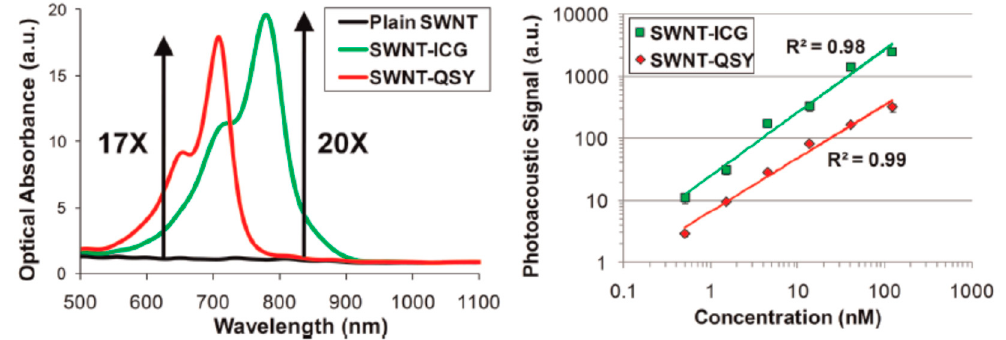
Figure 14. Comparison of absorbance ( left ) and optoacoustic signal ( right ) for ICG (green) and QSY 21 (red) labeled SWNTs. Figure from [101] reproduced with permission from the publisher. In animal testing, cRGD peptide-labeled SWNTs were found to target U87MG tumor xenografts. Moreover, spectral unmixing allowed for clear delineation of the two dyes, even in complex biological media as shown in Figure 15.